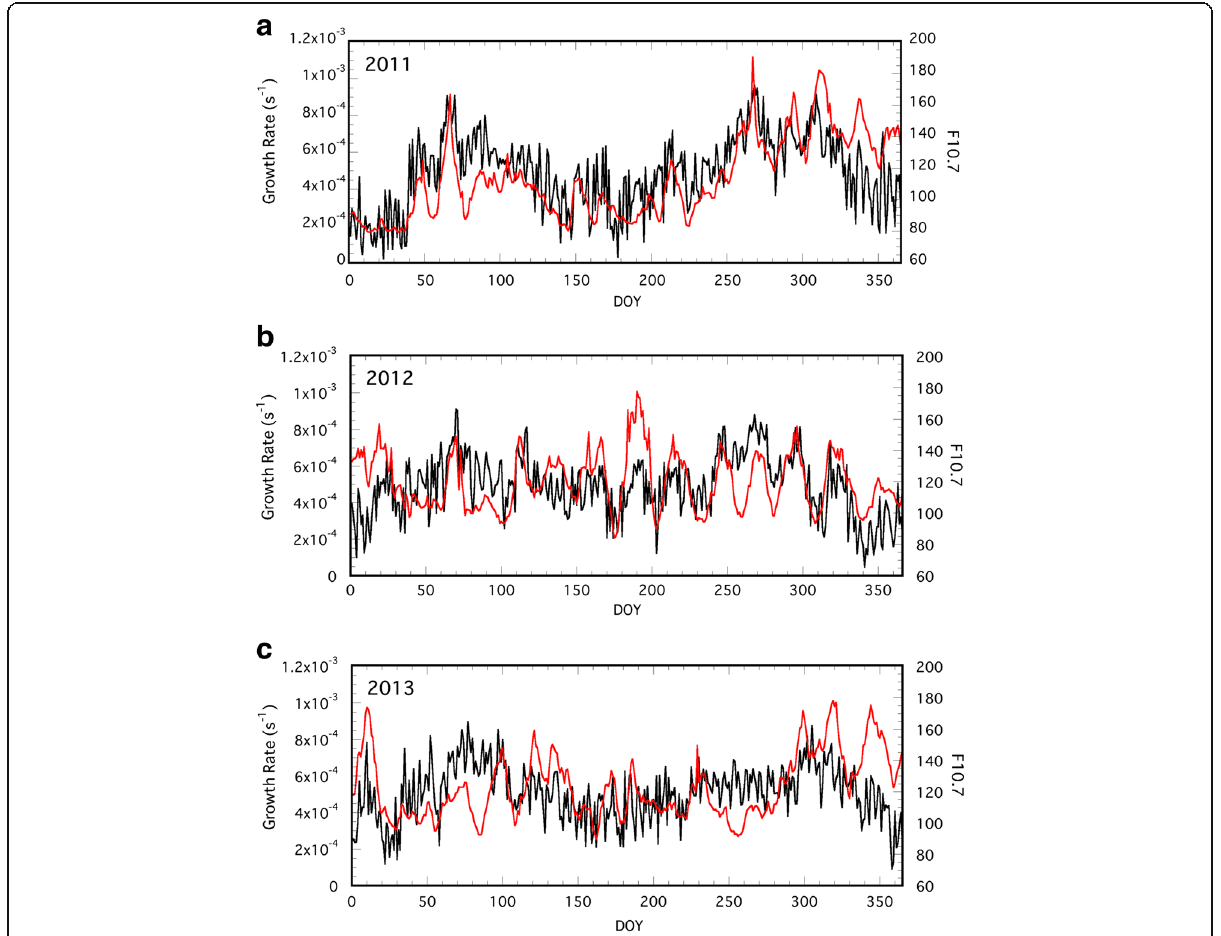
Fig. 10 Daily variations in R-T growth rate and the observed daily F 10.7 . The R-T growth rate in GAIA at 100°E and the observed daily F 10.7 are shown for a 2011, b 2012, and c 2013. Black lines indicate the daily maximum values of the R-T growth rate and red lines indicate the daily values of F